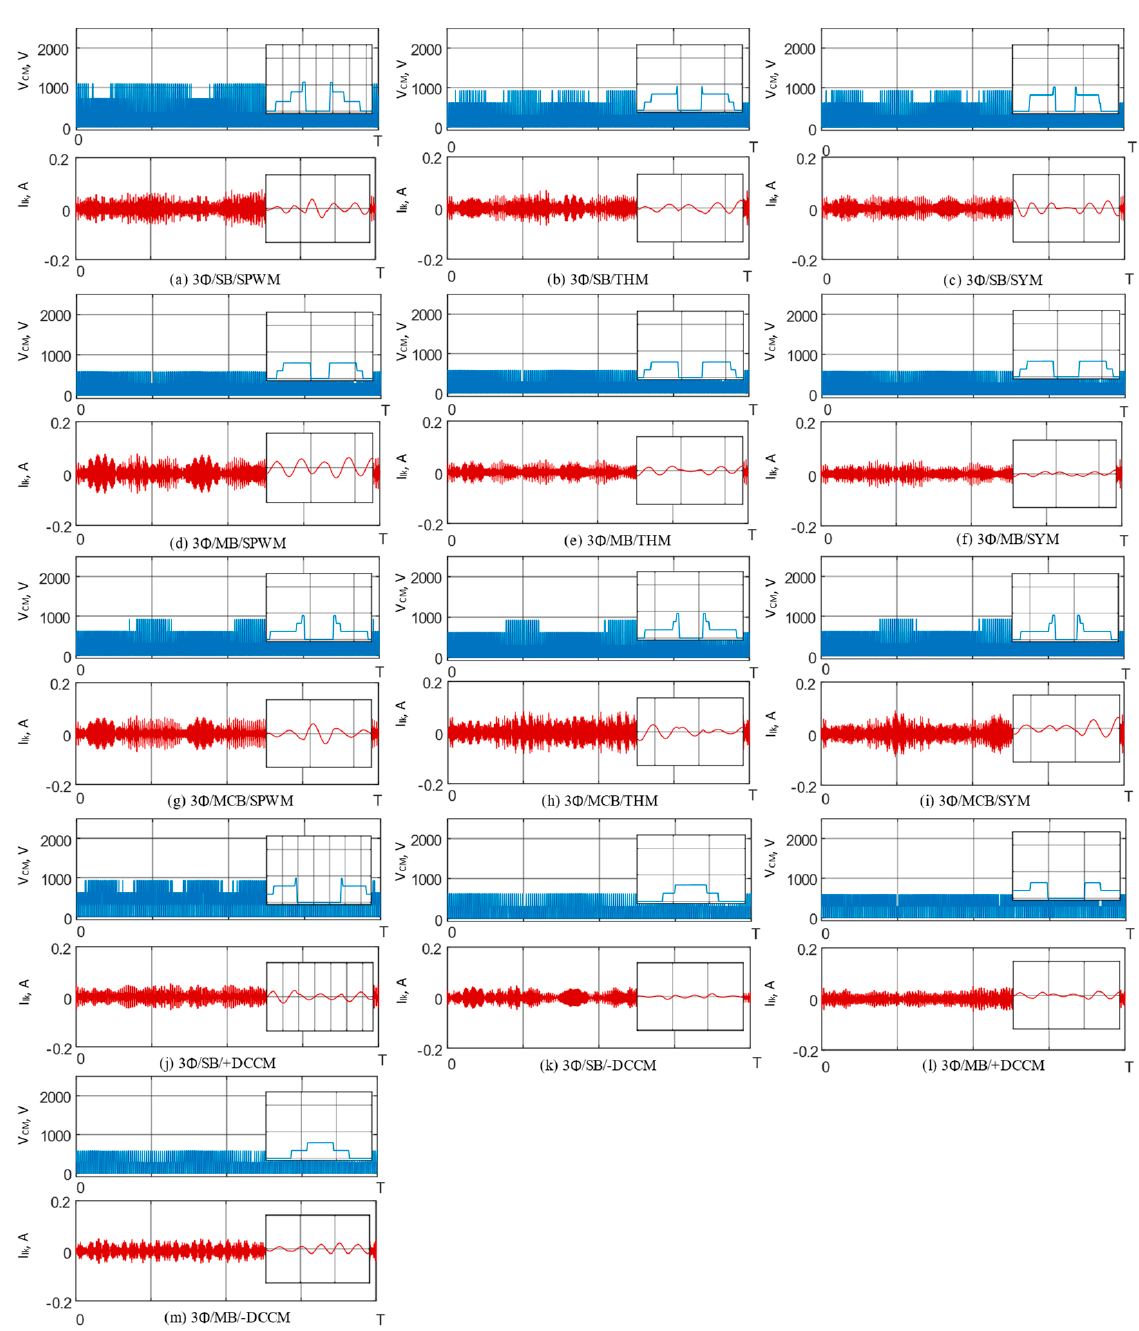
Figure 11. CMV and leakage current waveforms at 𝑉 (cid:3043)(cid:3035) = 220 V for 3 ф ST schemes.